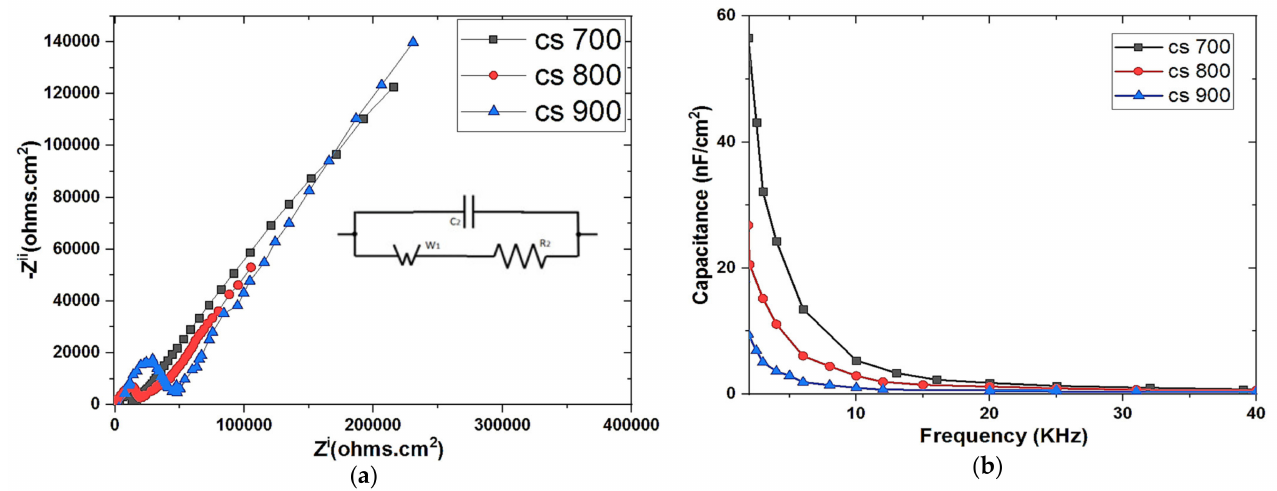
Figure 5. Nyquist plot of ( a ) CS 700, 800, and 900 respectively; ( b ) theoretical capacitance of CS 700, CS 800, and CS 900 as a function of frequency.